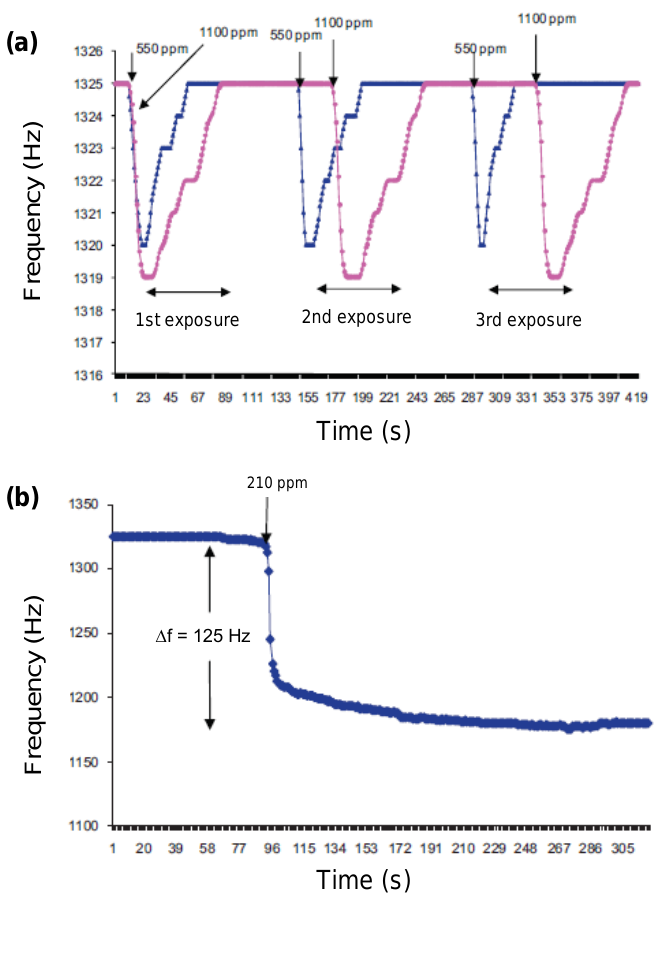
Figure 7. Responses of DMMP gas sensor toward ( a ) methanol and ( b ) DMMP. Adapted with permission from [45]; Copyright 2010, Elsevier